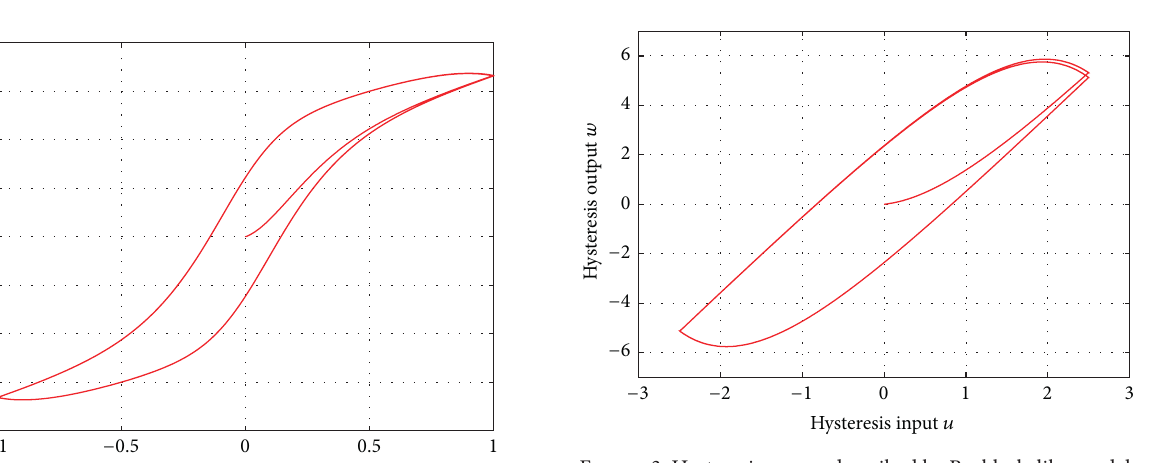
Figure 3: Hysteresis curves described by Backlash-like